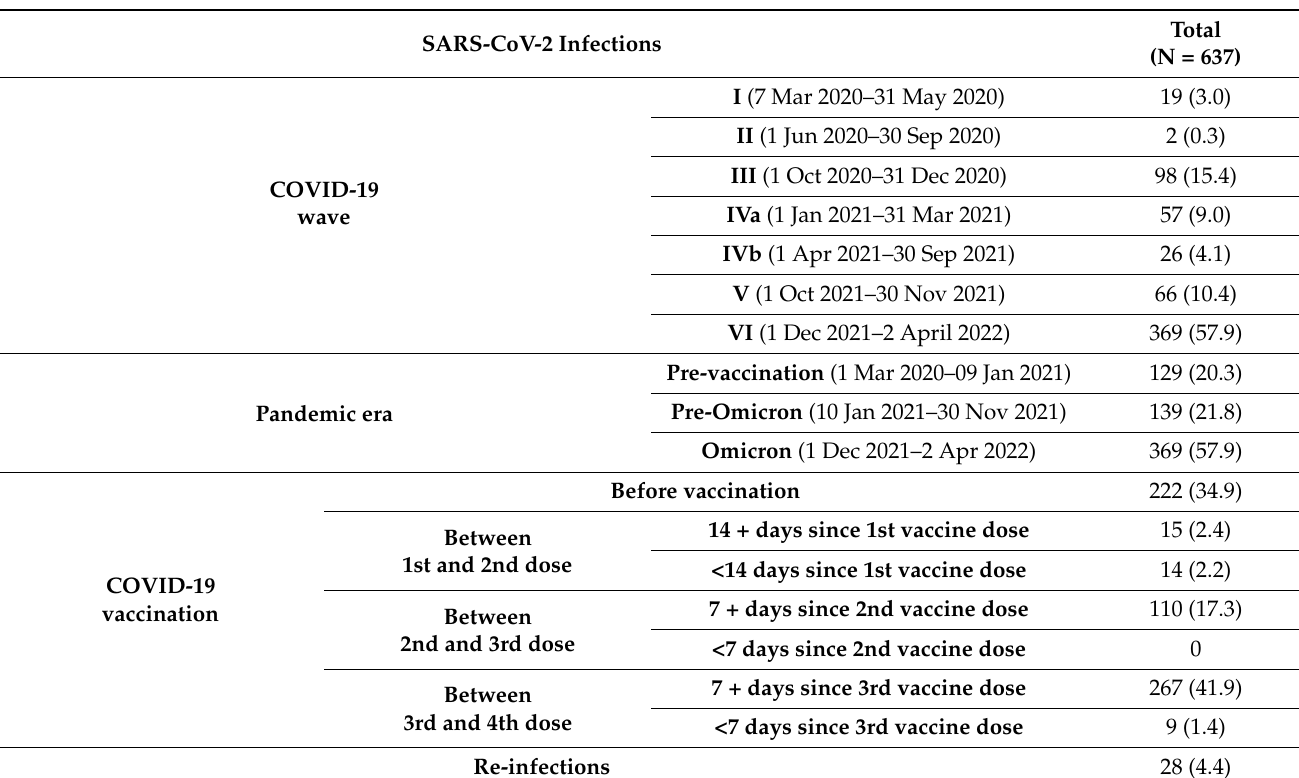
Figure 3. Monthly incidence (%) of SARS-CoV-2 infections in healthcare workers (HCWs) versus the university staff of Trieste. Table 3. Distribution of SARS-CoV-2 infections by COVID-19 wave and number of vaccine doses received. Number (N) and column percentage